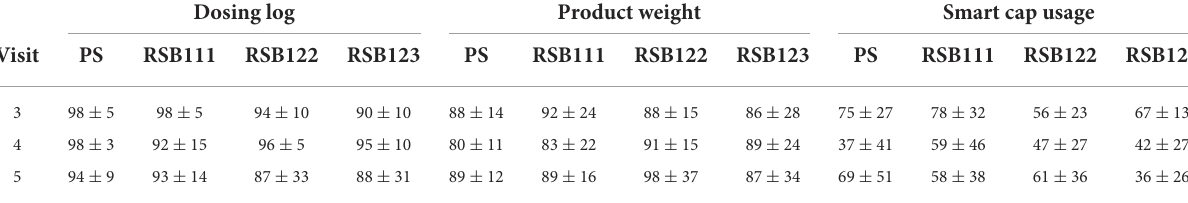
TABLE 4 RSB intake presented as a percentage compliance to protocol-directed doses, ITT analysis. Dosing log